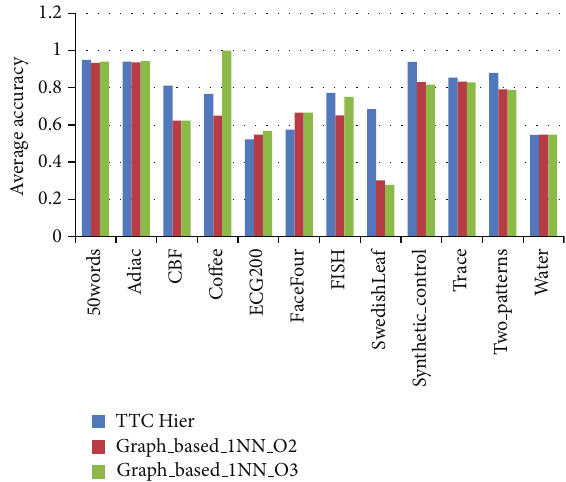
Figure 6: Quality of clustering using the graph-based approach as compared with